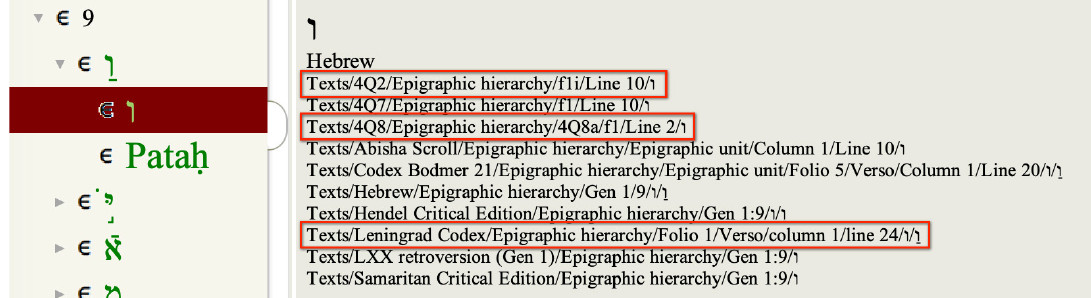
Figure 7: A character ( vav ) in the Hebrew content pool and the multiple hierarchies to which it is assigned; notice especially 4Q2, 4Q8, and the Leningrad